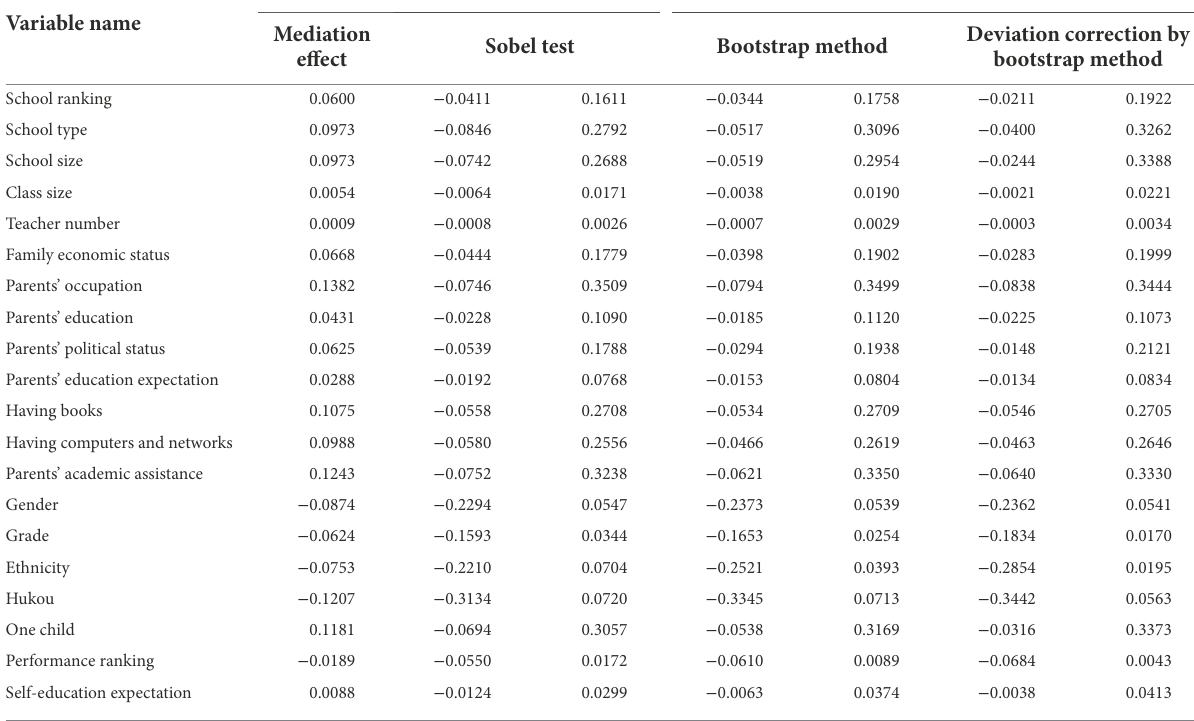
TABLE 4 Mediation effect of shadow education (Chinese scores).